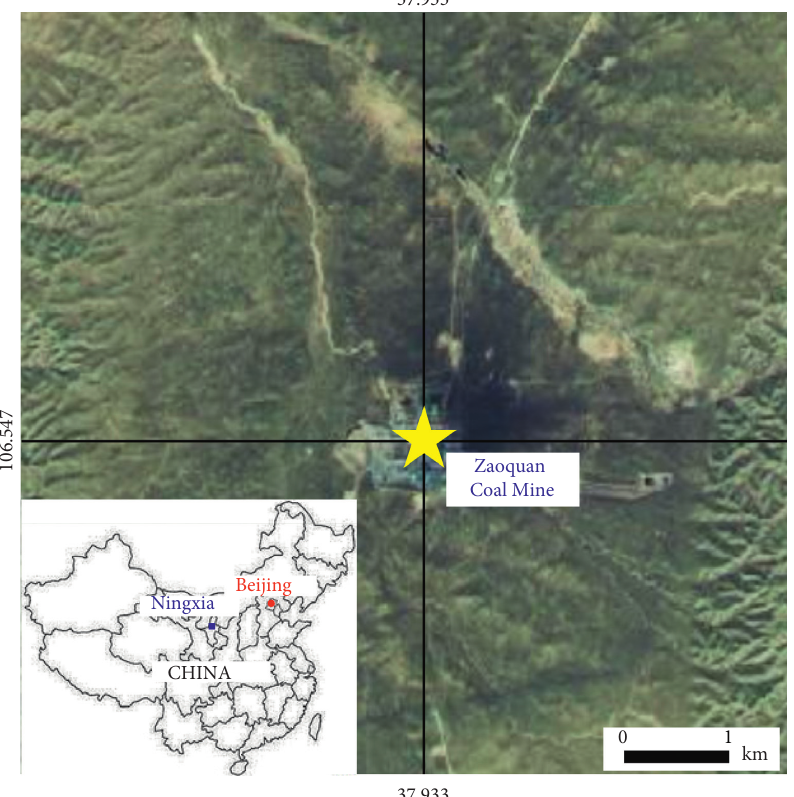
Figure 1: Floor heave of return airway in no. 130203 working face.